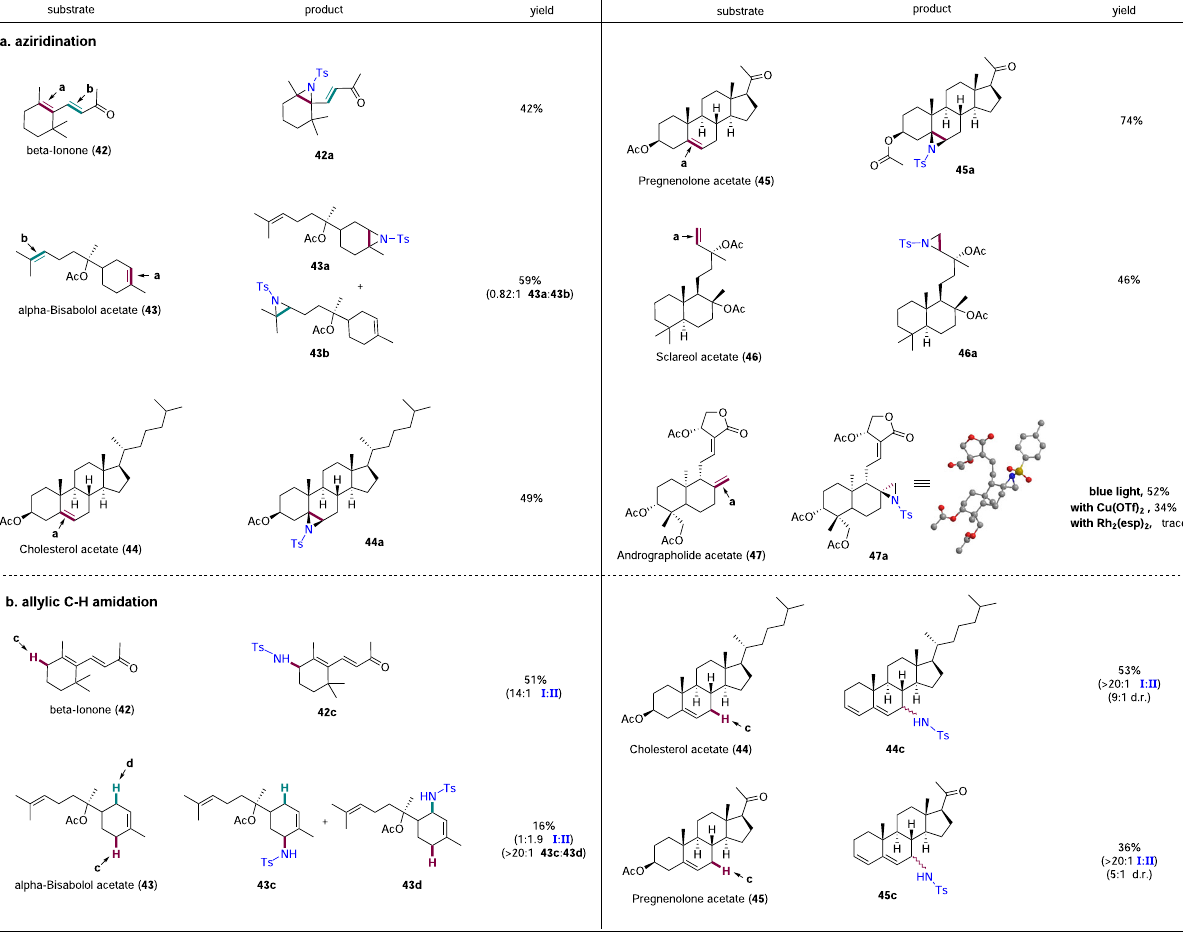
Fig. 3 Synthetic application. a Late-stage aziridination of biologically active natural products. Reaction conditions: 1 (0.05 mmol), natural products (0.1 mmol), in CH 3 CN (0.5 mL) under 12 W blue LEDs (435 – 445 nm) at room temperature for 7 h. Isolated yield. b Late-stage allylic C – H amidation of biologically active products. Reaction conditions: 1 (0.1 mmol), natural products (0.2 mmol), [Cu(OTf)] 2 ·toluene (10 mol%), L 9 (15 mol%), 4ÅMS (100 mg), DCE (0.9 mL), r.t., under N 2 for 16 h. Isolated yield. The ratio of isomers is given in the parenthesis. The ratio of C – H amidation/aziridination product ( I : II ) is given in the